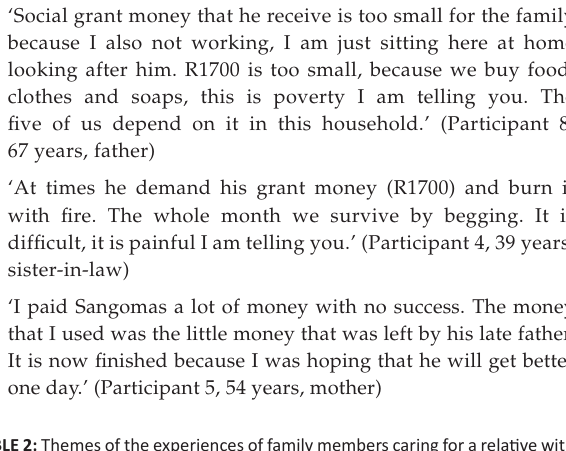
TABLE 2: Themes of the experiences of family members caring for a relative with substance-induced psychosis disorder. Theme Catergories